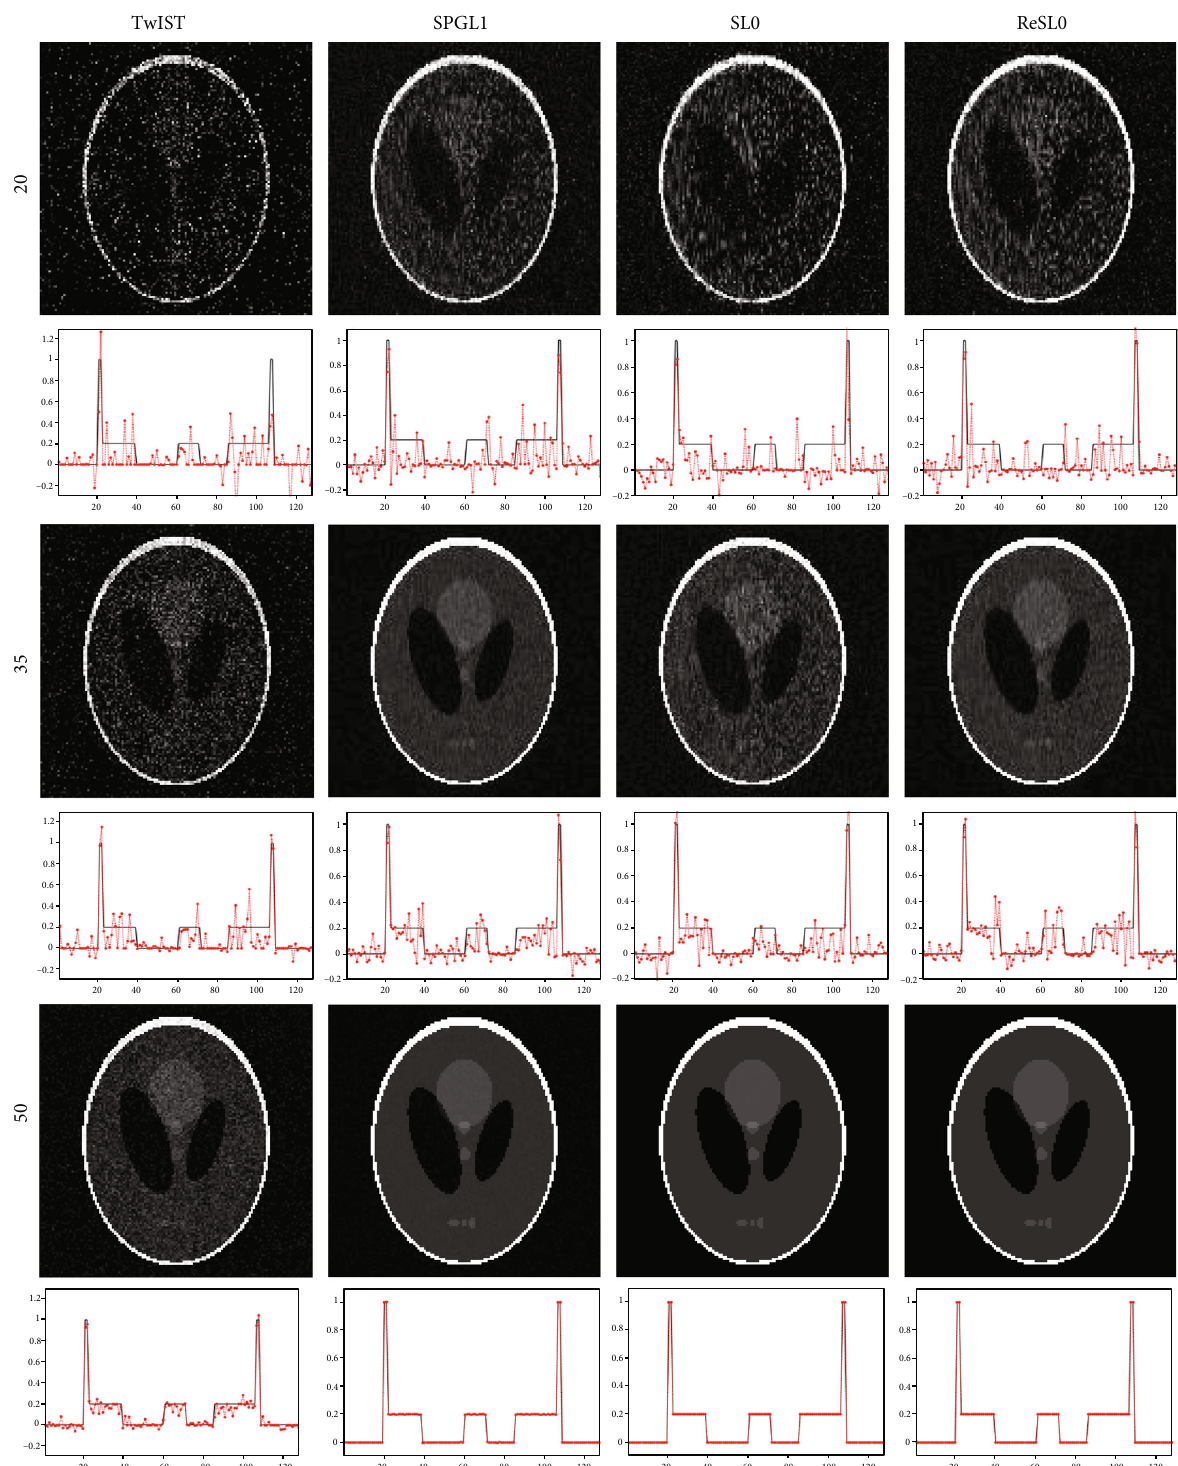
Figure 2: Reconstruction results of the Sheep-Logan phantom. The fi rst to the third rows are the reconstruction images with 20-view, 35- view, and 50-view that are uniformly distributed at a 360 ° curve. The fi rst to the fourth columns show the results of TwIST, SPGL1, SL0, and ReSL0